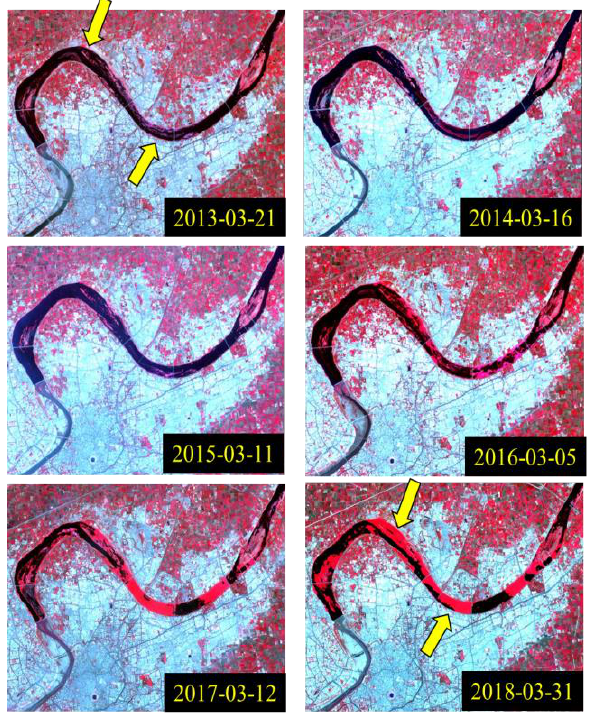
Figure 4. Multi-Year Observations of Macrophytes in Tapi River (Surat) from Resourcesat-2/2A (LISS-III) Series of Satellites